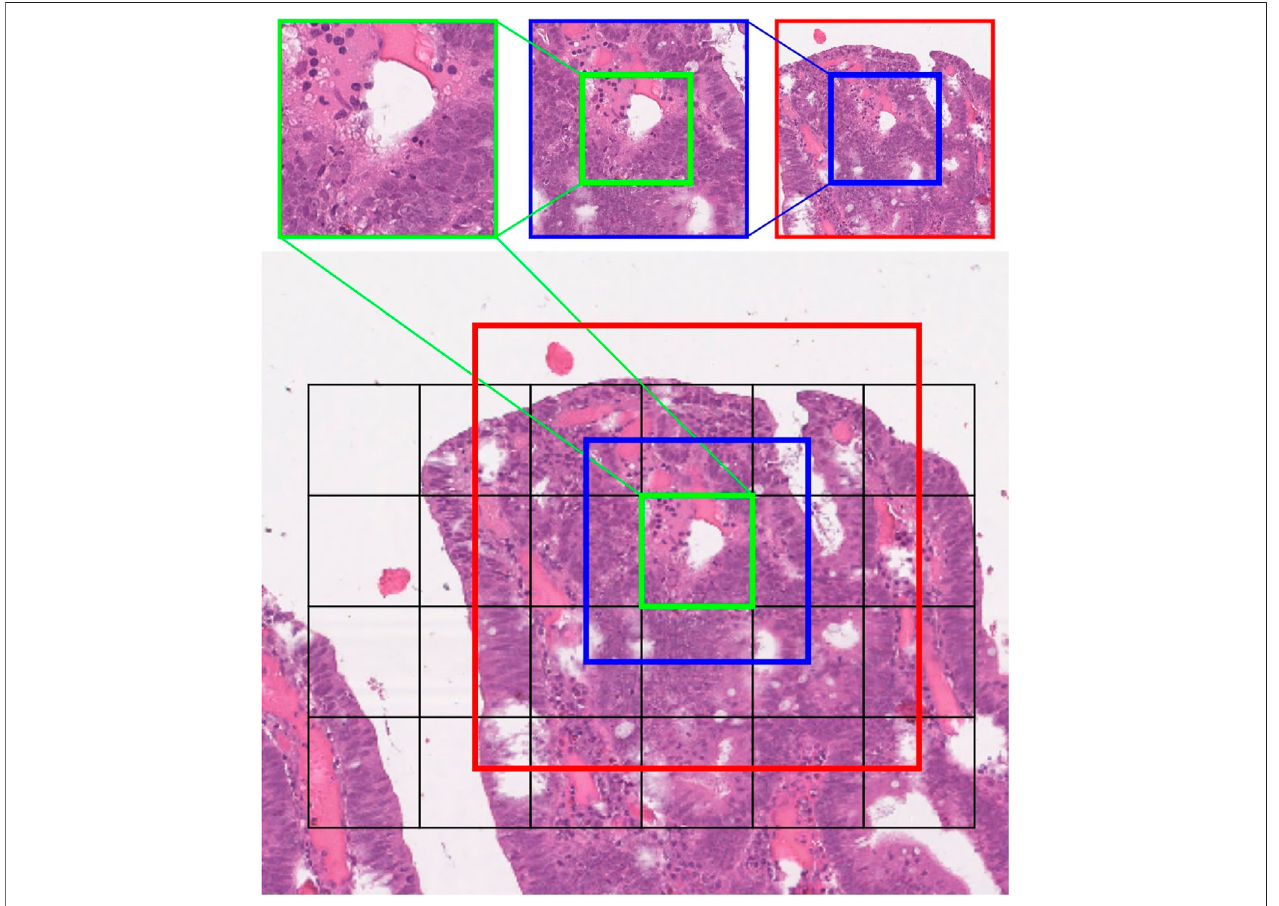
FIGURE4| Anexampleofthe multi − center extractionmethod.Thegridismadeaccordingtothehighestmagni fi cationlevelselectedbytheused.Thepatchisthe centroid for patches at lower magni fi cation levels.